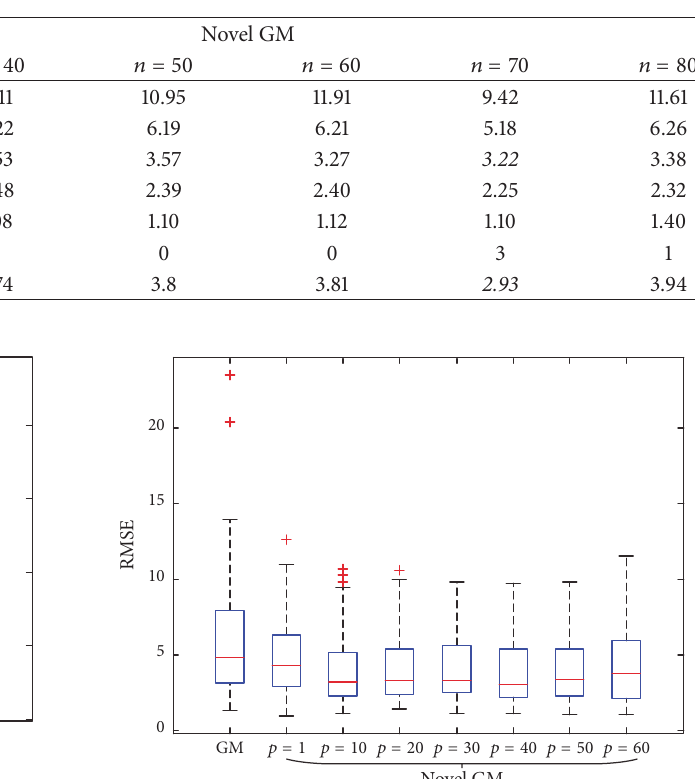
Table 2: Values of indicators in box plot of RMSEs at different values of 𝑛 in the novel GM and GM.